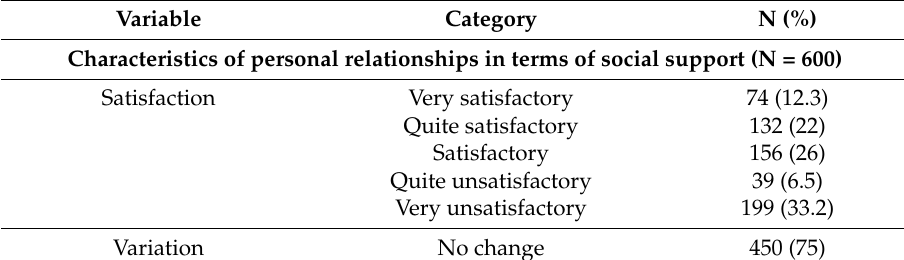
Table 2. Descriptive analysis of social support in personal